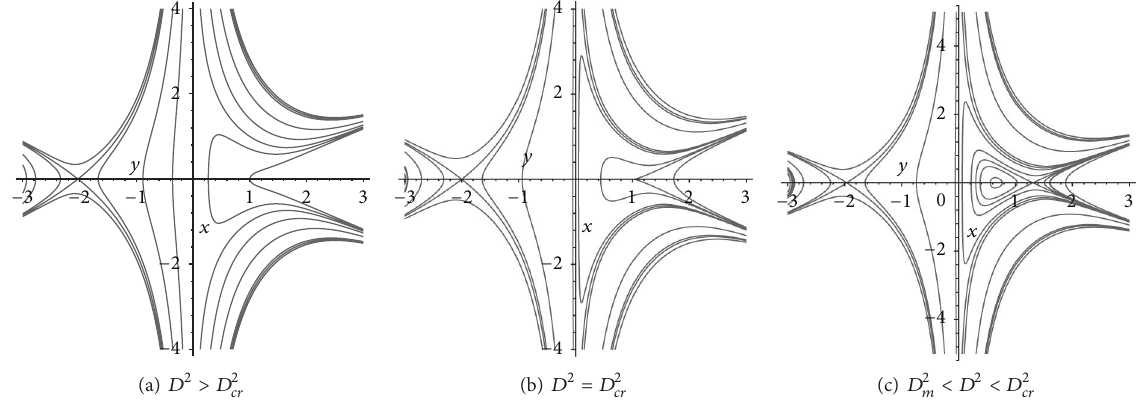
Figure 2: The phase portraits of system (6) for 𝑛 = 2𝑚 , 𝛽 > 0 , 𝐺 1 > 0 , and 𝜎 < 0